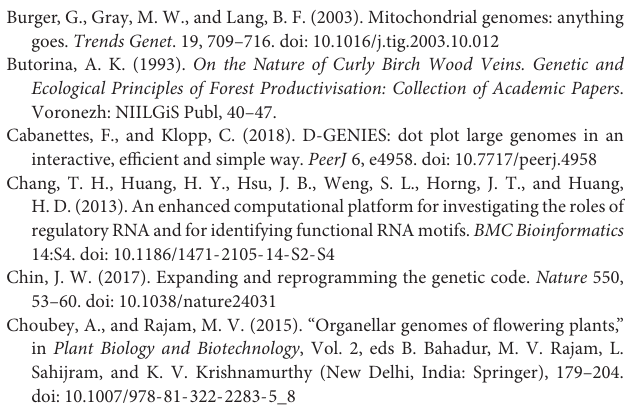
Supplementary Figure 1 | Multiple nucleotide sequence alignment of nine woody plant species plastomes from Spermatophyta (mVISTA). B. pendula var. carelica was used as a reference. Gray arrows above the alignment indicate the transcriptional directions of genes. Genome regions are color-coded as exon (violet) and conserved non-coding sequences (CNS) (red). A cut-off of 50% identity was used for the plots. The Y-axis indicates the percent identity between 50 and 100%. Supplementary Figure 2 | Multiple whole-plastome sequence alignment of eight birch species. Gray arrows above the alignment indicate the transcriptional directions of genes. Genome regions are color-coded. Supplementary Figure 3 | Dot plots of pairwise alignments of the B. pendula var. carelica (MG966529.2) complete plastome sequence vs. plastomes of eight birch